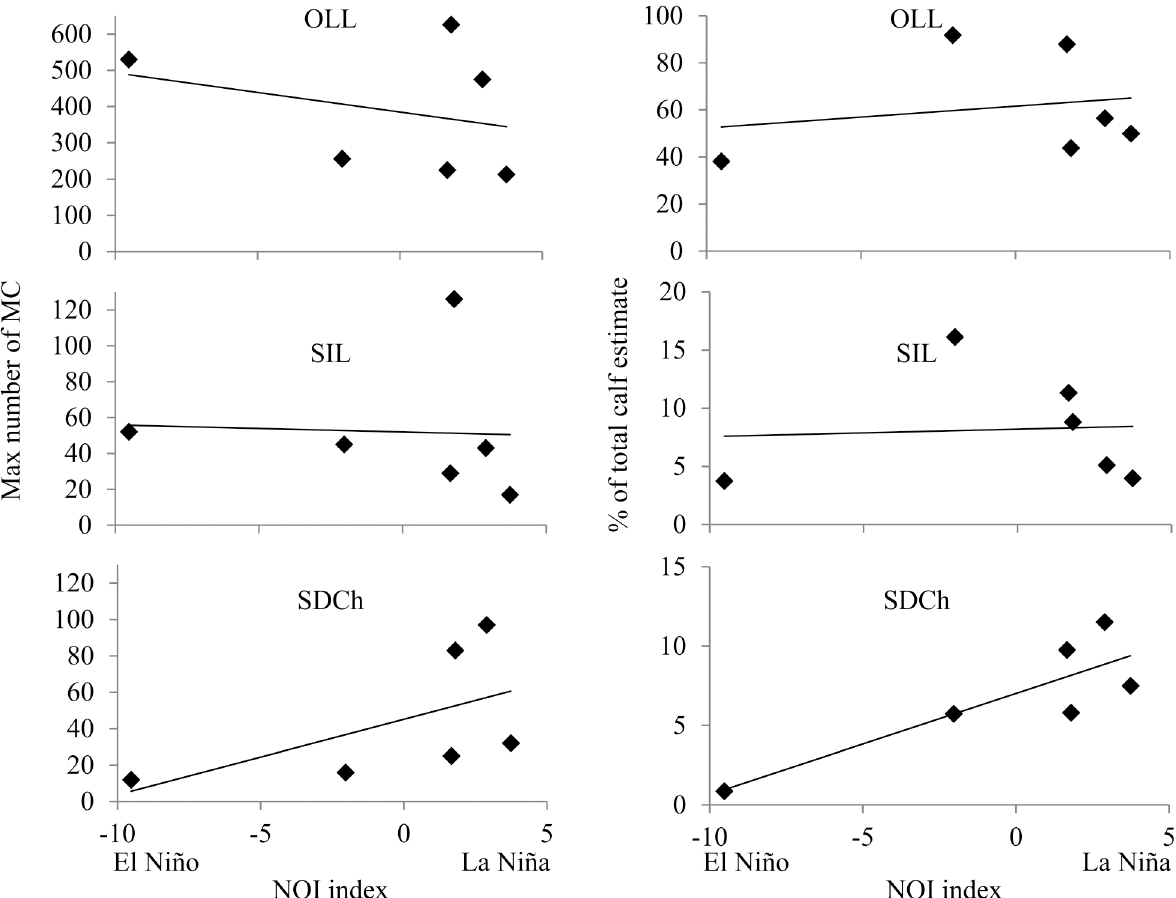
Fig 9. Mother-calf pairs distribution and ENSO conditions. Maximum counts of mother-calf pairs (MC) and the percent respect to the total calf estimate at Piedras Blancas for Santo Domingo Channel (SDCh) north of Bahía Magdalena, San Ignacio Lagoon (SIL), and Ojo de Liebre Lagoon (OLL) vs the Northern Oscillation Index (NOI) for the years 1997 –